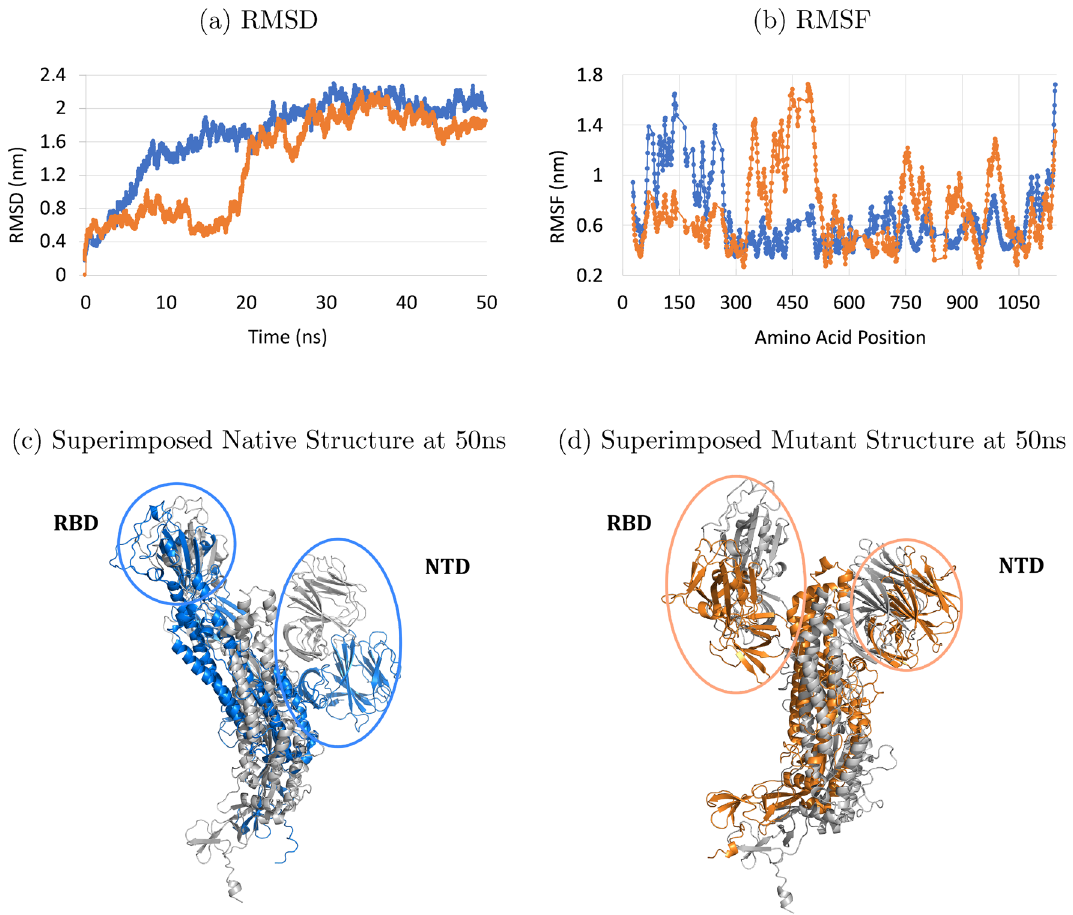
Figure 5. Full 50ns MD Simulation of the non-mutant native spike (blue) and the (R355D K424E) mutant structure (orange). Subfigures ( a ) and ( b ) report the RMSD and RMSF plots, respectively, of the MD simulation run, ( c ) superimposing the non-mutant structure at time 50ns (blue) on the native structure at time 0ns (gray), and ( d ) superimposing the 2-point mutant structure at time 50ns on its starting conformation at time 0ns